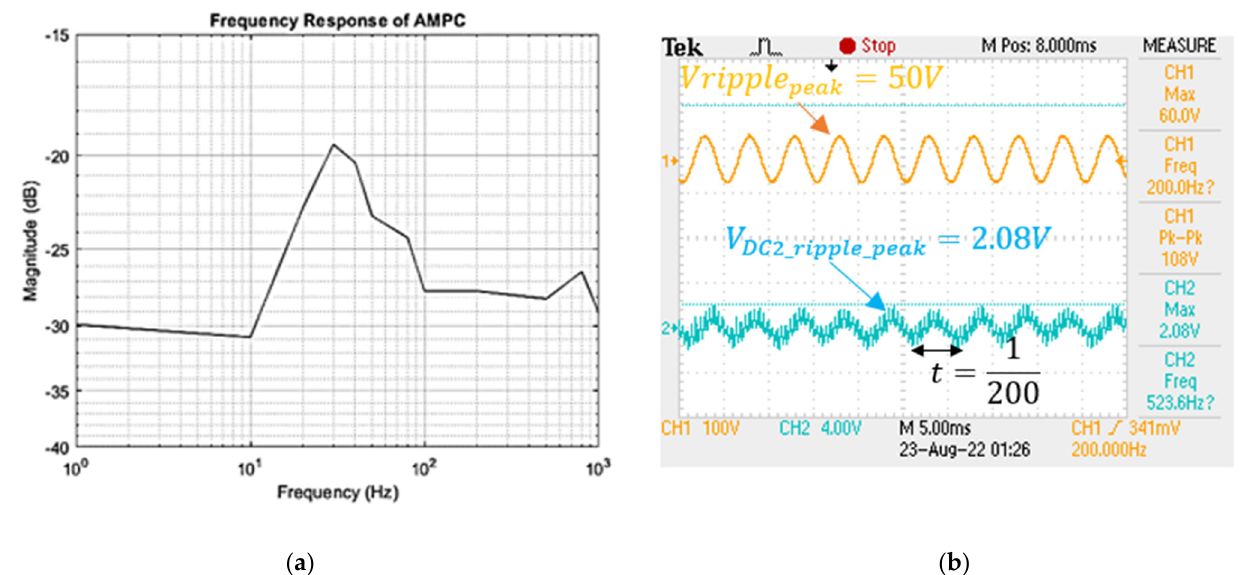
Figure 15. Source voltage disturbance rejection ( a ) frequency response, ( b ) measures of 𝑉 (cid:3043)(cid:3032)(cid:3028)(cid:3038) and 𝑣 (cid:3045)(cid:3036)(cid:3043)(cid:3043)(cid:3039)(cid:3032) for 200 Hz .